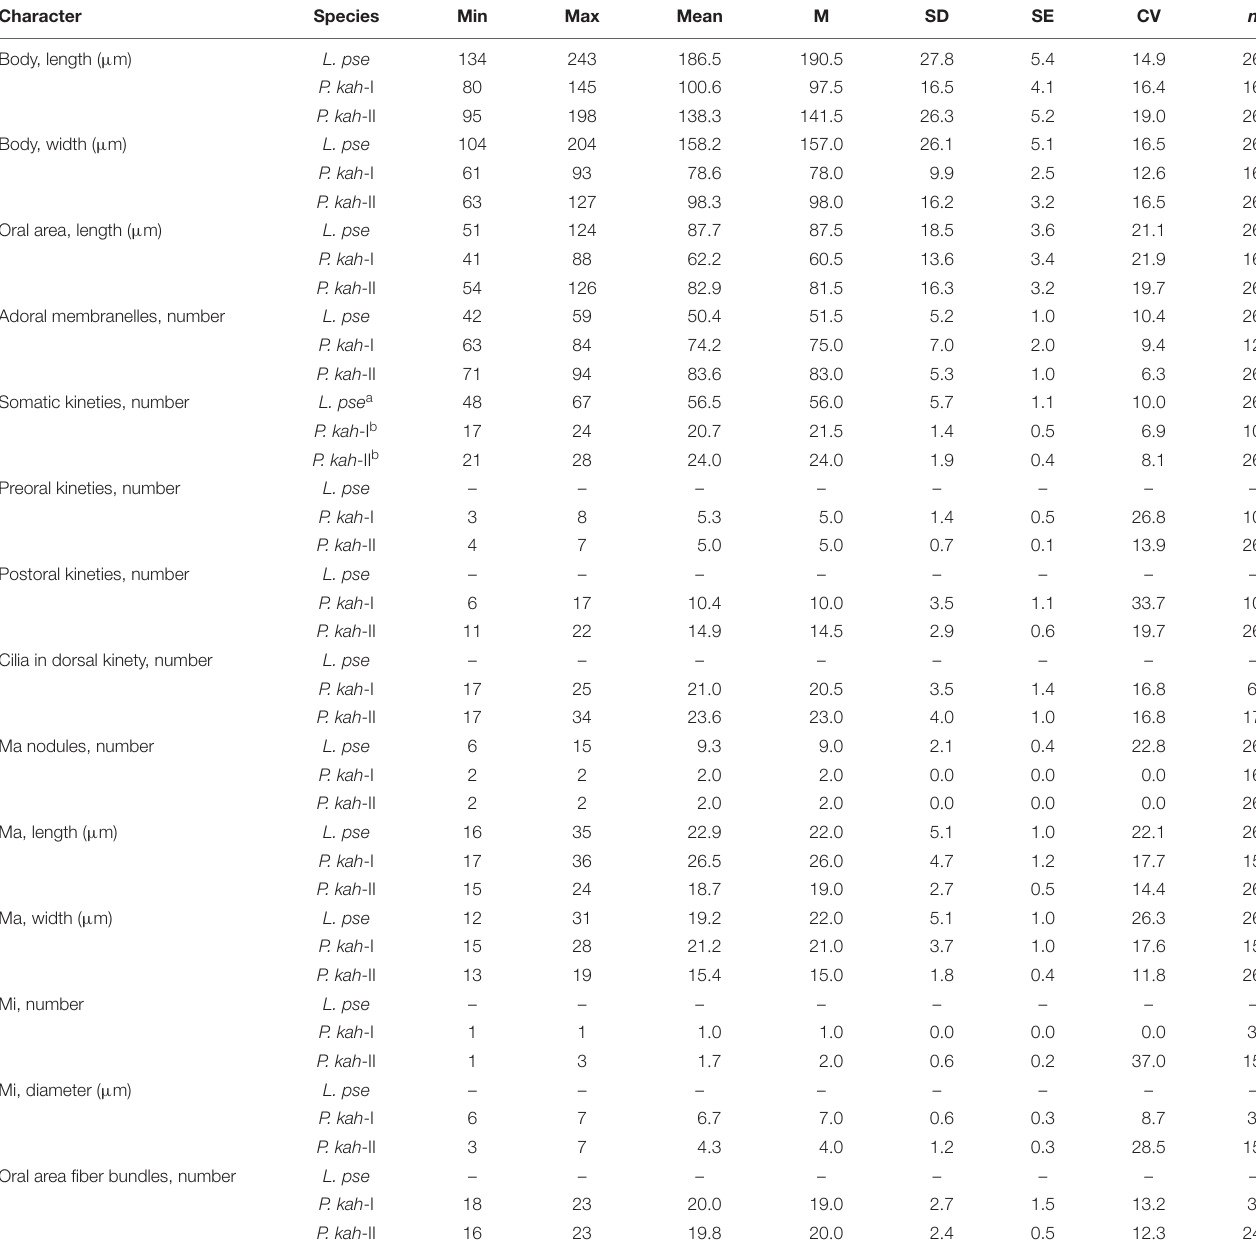
TABLE 1 | Morphometric data on Linostomella pseudovorticella n. sp. ( L. pse ) and Peritromus kahli population-I, Meishan Island population ( P. kah- I), and population-II, Xiangshan Bay population ( P. kah-